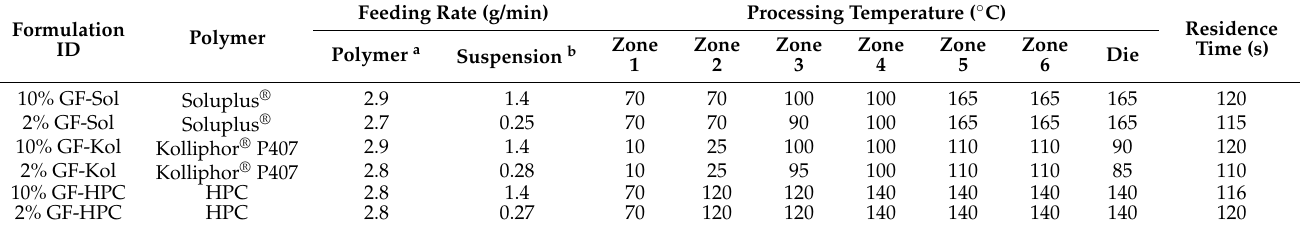
Table 2. Process parameters used in the nanoextrusion experiments for various formulations.